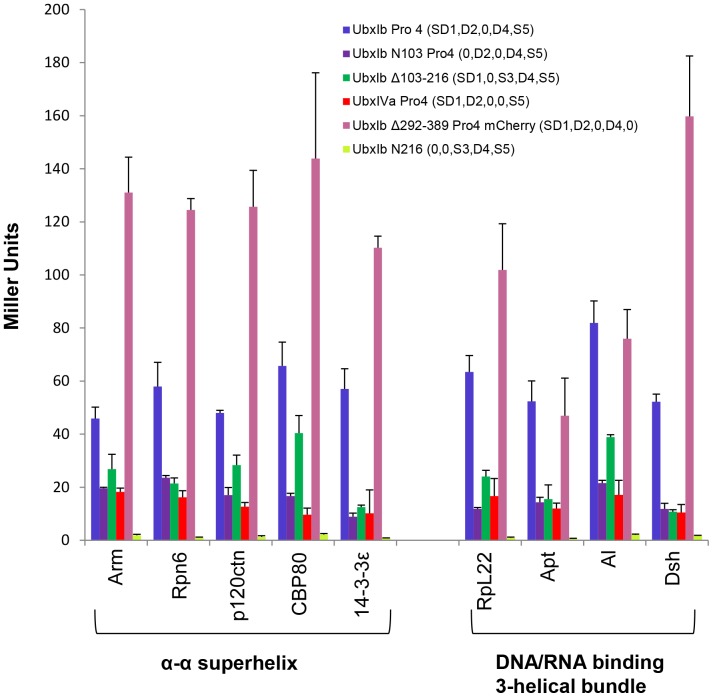
Partner proteins bind more than one region in Ubx.Yeast two-hybrid results for Ubx variants in which each region of Ubx has been sequentially mutated or deleted. Each of these variants retain some ability to bind Ubx relative to UbxIbN216 (0,0, S3, D4, S5). Partners are grouped based on the fold they have in common.